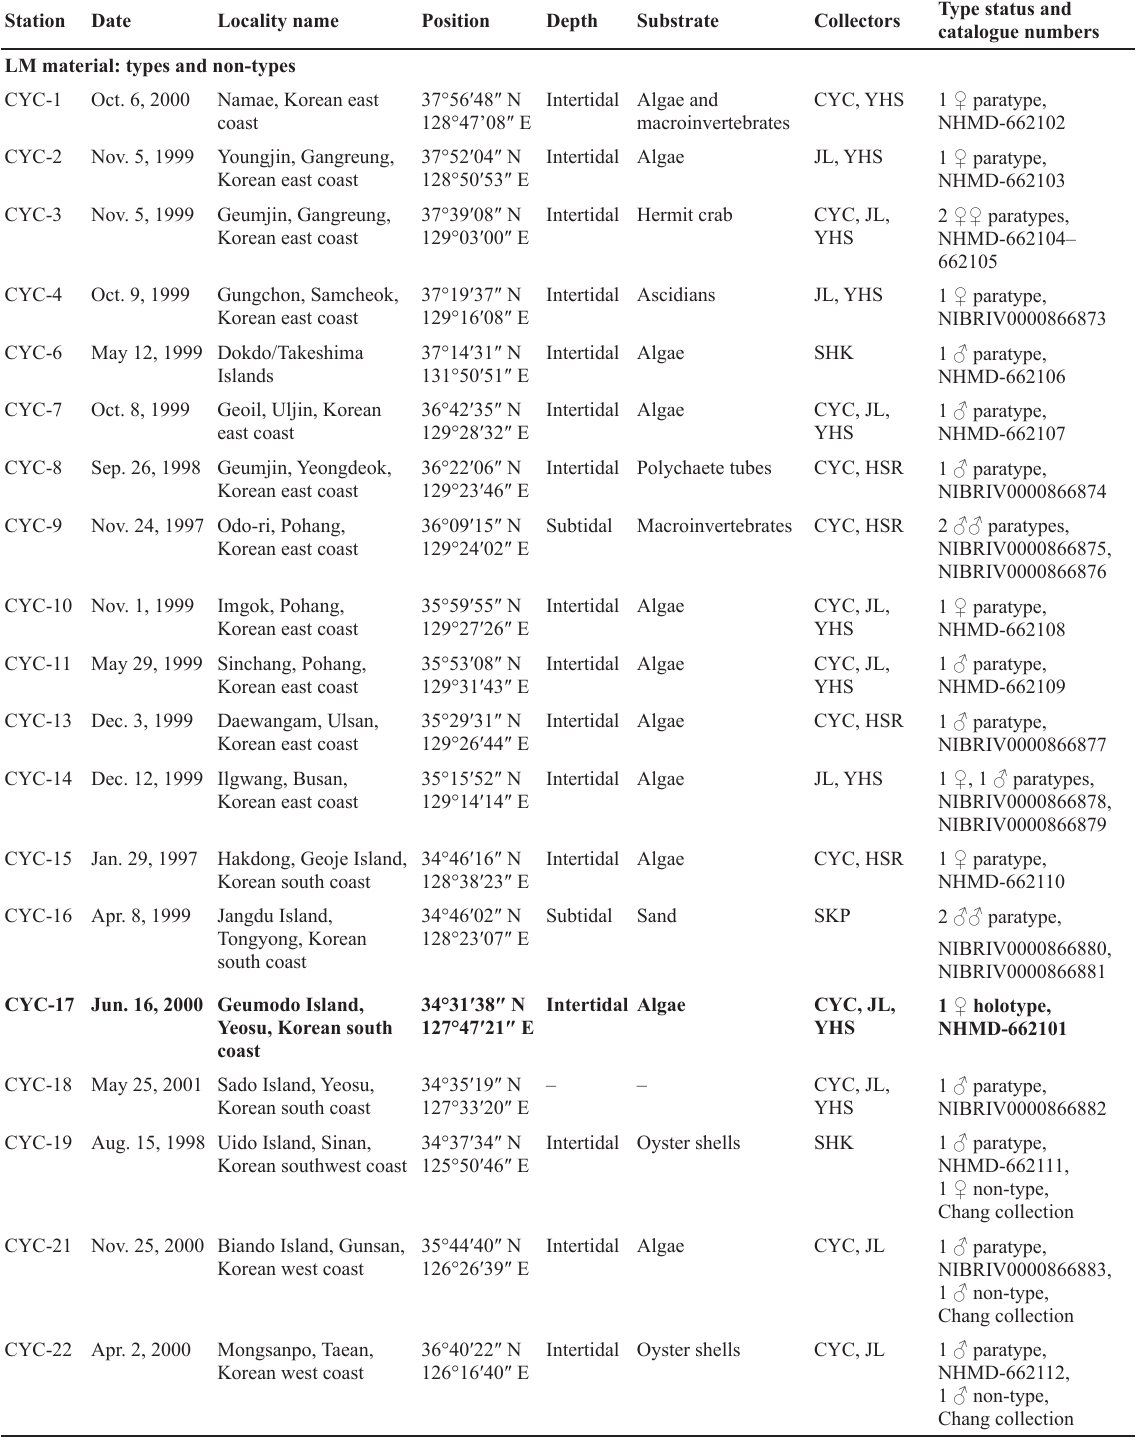
Table 14 (continued on next page). Summary of collecting data for Echinoderes songae Sørensen